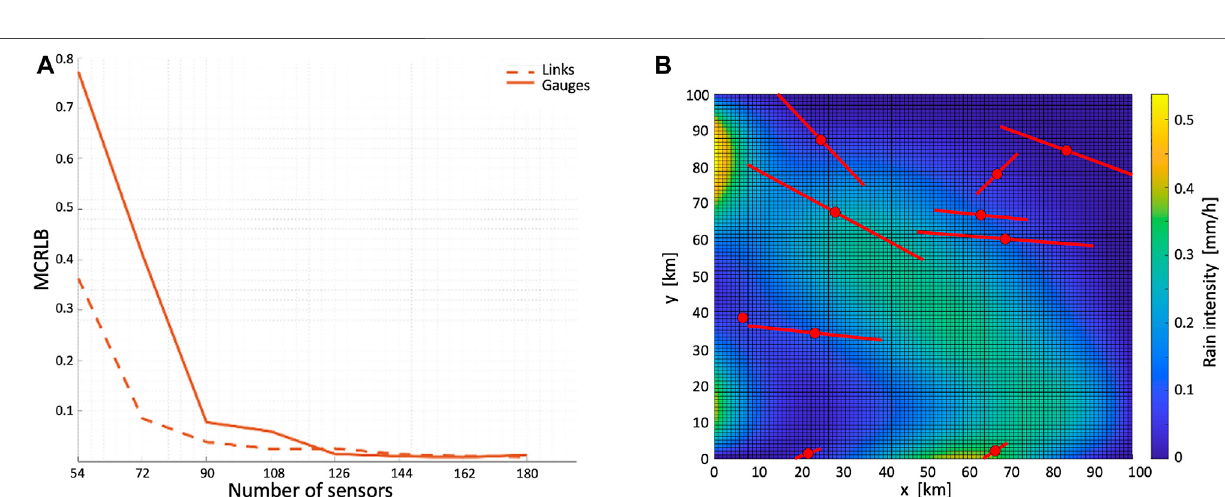
Frontiers in Signal Processing |